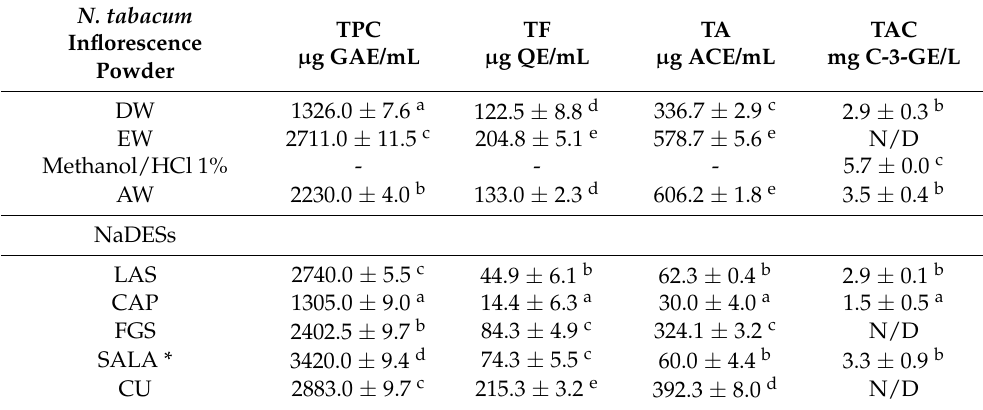
Table 3. Phenolic compounds, total flavonoids, total anthocyanins, and total alkaloids con- tent of Nicotiana tabacum var. Virginia inflorescence powder extracts using conventional and non-conventional